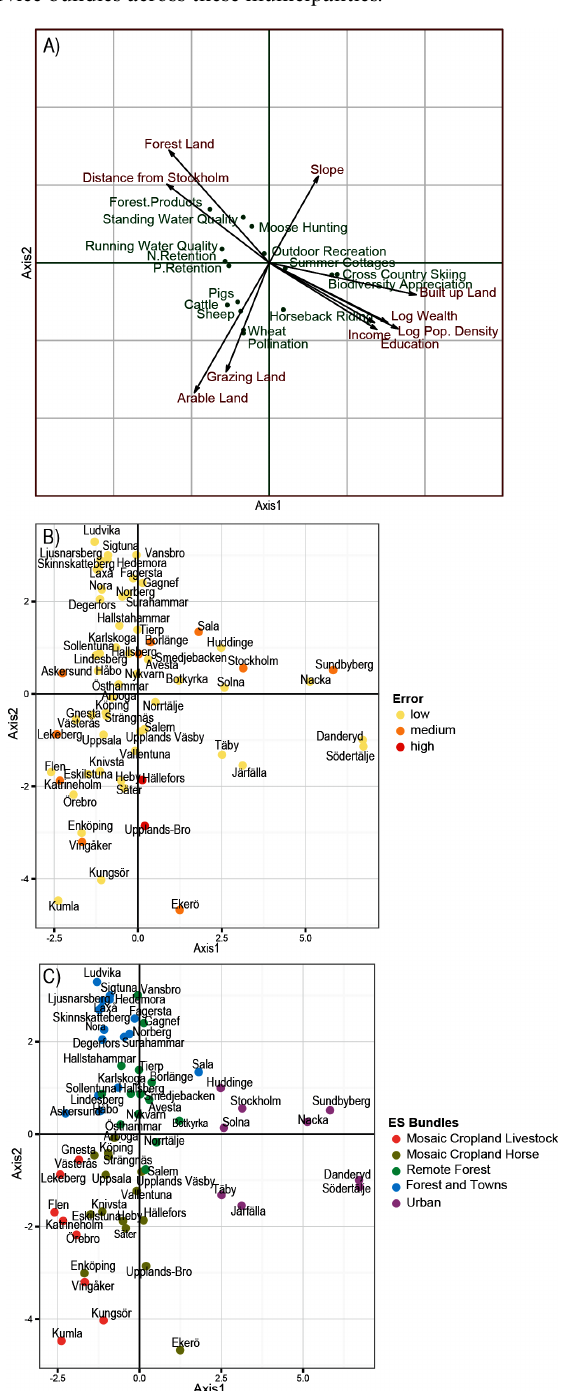
Fig. 3 . Principal component analysis of instrumental variables (PCAIV) of ecosystem services with respect to drivers as well as variance among municipalities. The X axis corresponds to rural to urban gradient (left → right), while the Y axis is shows a gradient between agricultural and forest land (bottom → top). The three plots represent (a) Distribution of individual ES and drivers, (b) Distribution of the 62 municipalities of the Norrström drainage basin, (c) Distribution of the ecosystem service bundles across these municipalities.